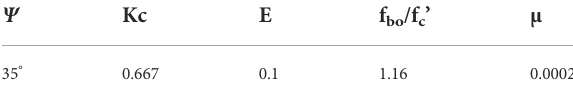
TABLE 2 Concrete damaged plasticity